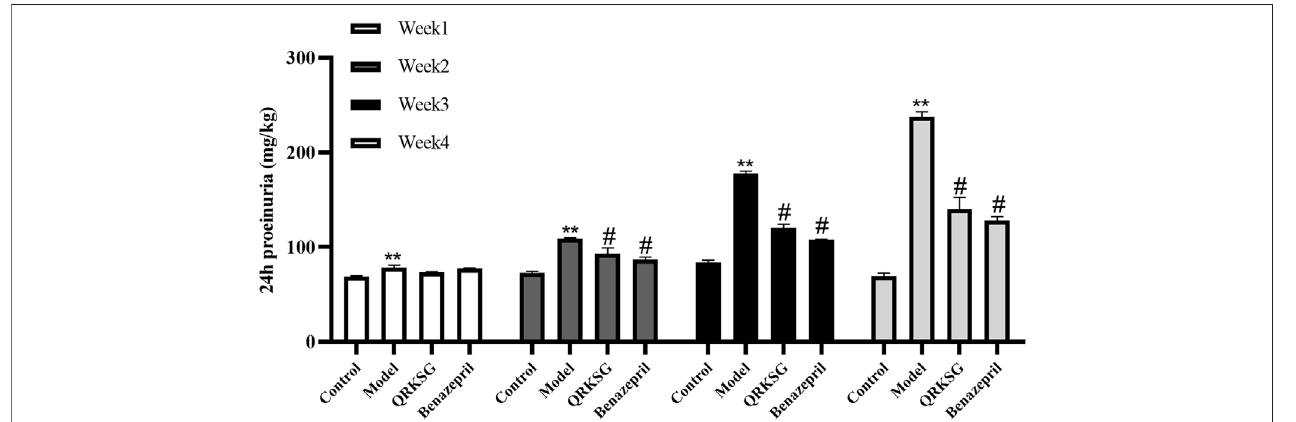
FIGURE 3 | 24 h proteinuria in normal and NS model rats. The data are presented as mean ± SD, ** p < 0.001 shows comparison against the control group; # p < 0.05 shows comparison against the model group.